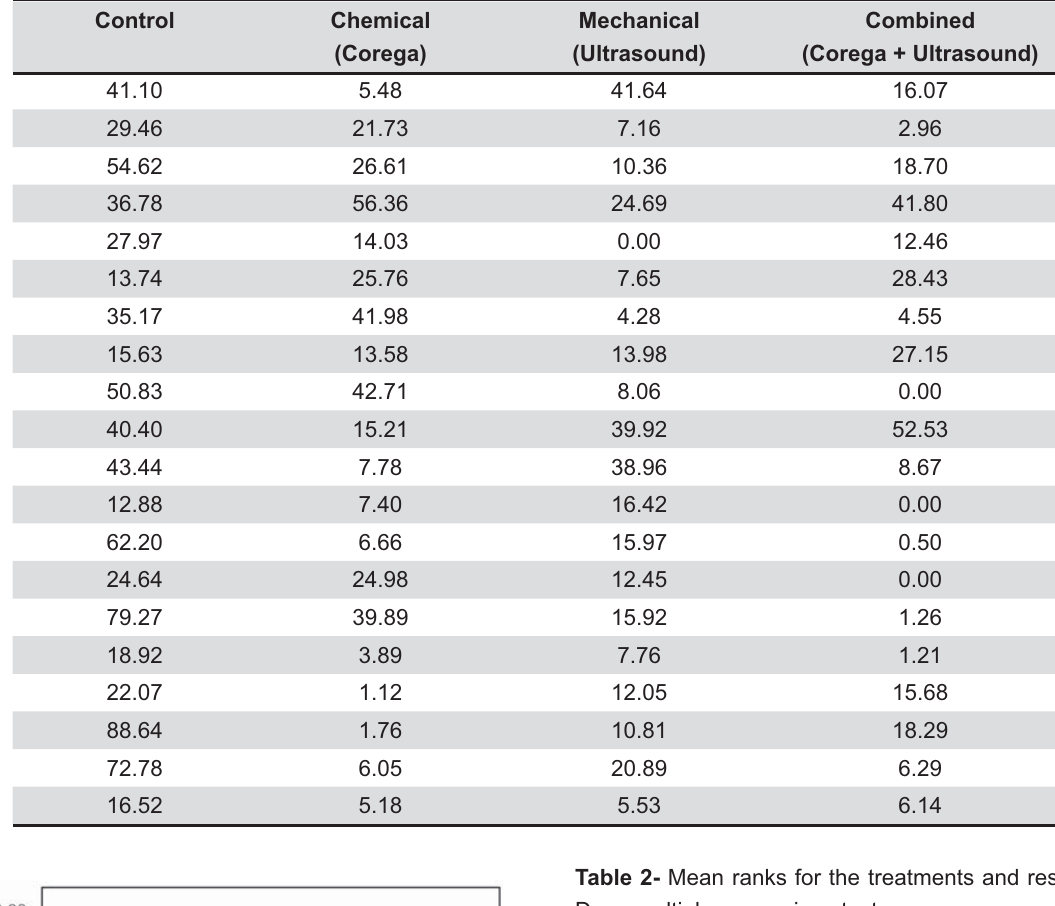
Table 1- (cid:2)(cid:3)(cid:4)(cid:5)(cid:6)(cid:4)(cid:7)(cid:8)(cid:9)(cid:10)(cid:4)(cid:11)(cid:2)(cid:12)(cid:13)(cid:2)(cid:14)(cid:15)(cid:12)(cid:16)(cid:17)(cid:18)(cid:2)(cid:9)(cid:13)(cid:8)(cid:4)(cid:5)(cid:2)(cid:8)(cid:19)(cid:4)(cid:2)(cid:20)(cid:11)(cid:4)(cid:2)(cid:12)(cid:13)(cid:2)(cid:4)(cid:9)(cid:6)(cid:19)(cid:2)(cid:18)(cid:4)(cid:8)(cid:19)(cid:12)(cid:21)(cid:2)(cid:8)(cid:4)(cid:11)(cid:8)(cid:4)(cid:21)(cid:2)(cid:13)(cid:12)(cid:5)(cid:2)(cid:22)(cid:23)(cid:2)(cid:21)(cid:9)(cid:24)(cid:11)